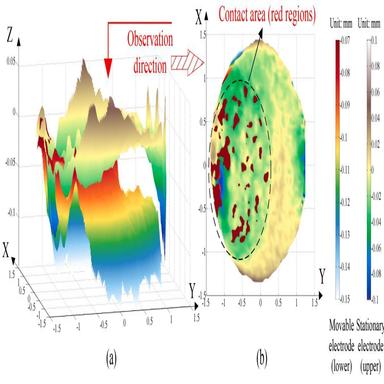
Simulated contact regions on the stationary contact surface. (a) Simulation of closing state. (b) Observation of contact area in the Z-direction.